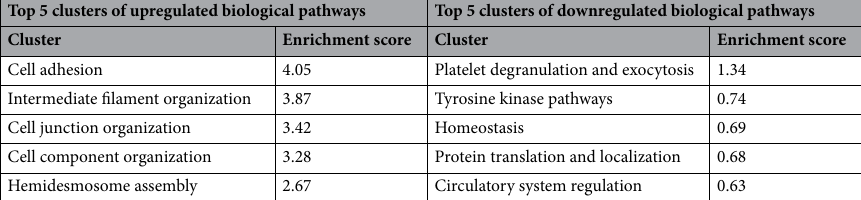
Table 6. Top 5 Clusters of Upregulated and Downregulated Biological pathways.